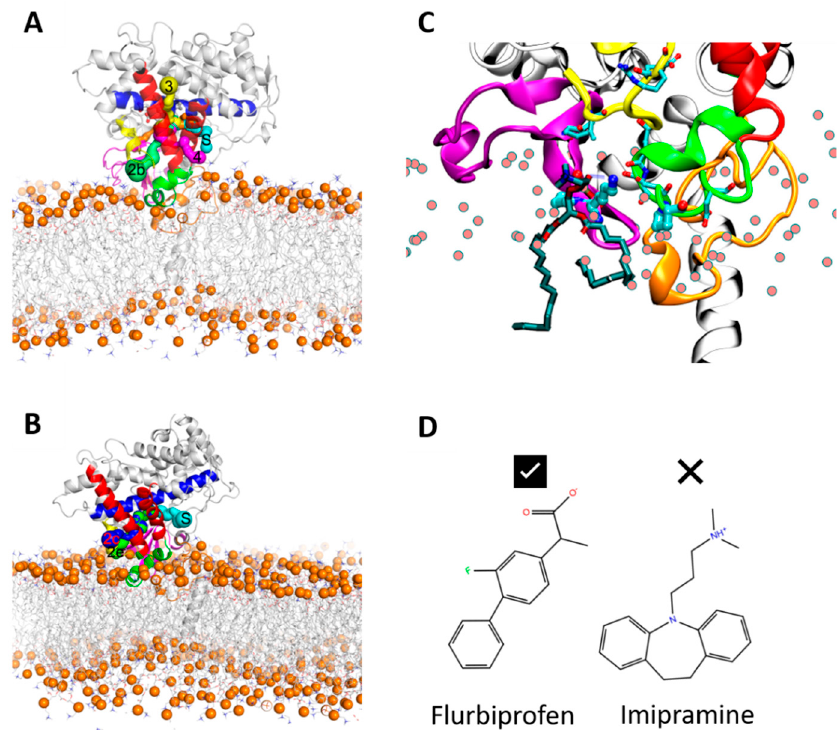
Figure 6. Initial ( A ) and final ( B ) snapshots of the AA MD simulation (SIM1) of the apo form of CYP 2C9, showing tunnels accessible to a water molecule probe between the active site and the protein surface. Tunnel 2b (green) connects the active site and the membrane and is present in both snapshots, as is tunnel S (cyan). Tunnel 3 (yellow) is present in the initial snapshot and tunnel 2c (blue) is present in the final snapshot. The protein and bilayer are shown with the same color scheme as in Figure 5. ( C ) Close-up view of the entrance to the 2b tunnel showing how the phosphate group of a phospholipid molecule (shown in stick representation colored by atom type with cyan carbons) makes a hydrogen bond with the amino group of K72 (all other lipid molecules are represented by spheres for the phorphorous atoms only; the protein is represented and colored as in Figure 5). This interaction is important for pulling the phospholipid molecule somewhat out of the membrane towards the tunnel to the active site. This motion leads to partial opening of the β -sheet and the F’–G’ regions; further opening would be required for a substrate molecule to access the active site. ( D ) K72 may interact analogously with acidic substrates, such as flurbiprofen, a drug that is a substrate of CYP 2C9 (left), and may repel basic substrates such as the tricyclic antidepressant (TCA) drug, imipramine, which is a substrate of CYP 2C19 (right).